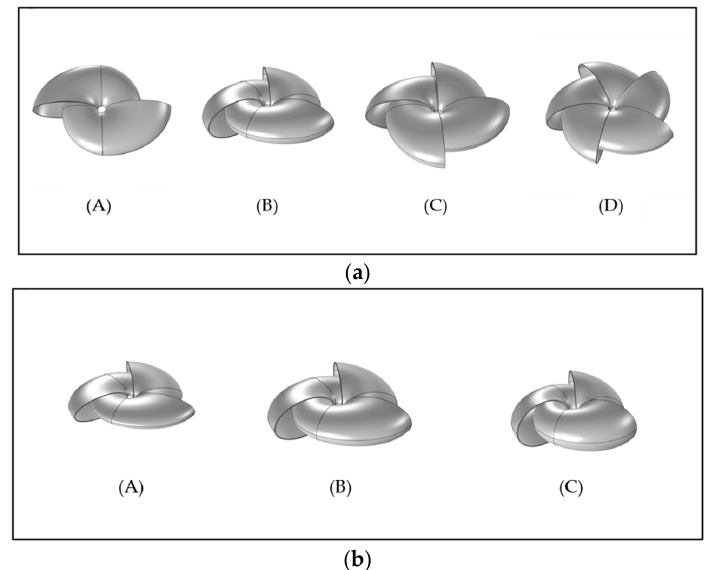
Figure 9. ( a ) Wind turbine with different number of blades; ( b ) Wind turbine with different ratio of major axis to minor axis of blade inlet section.